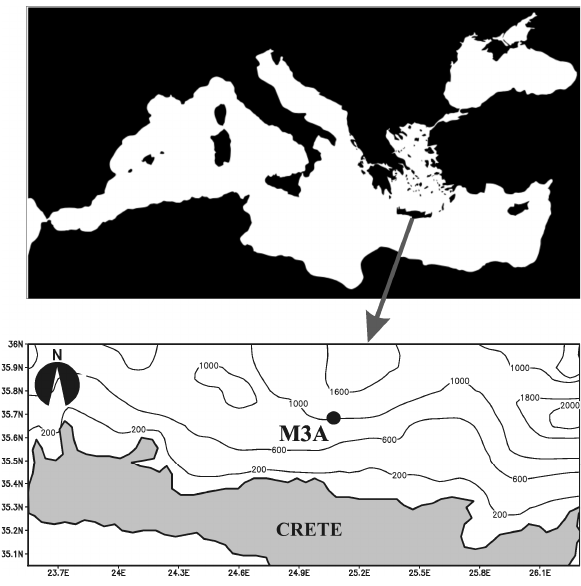
Fig. 1. Map of M3A